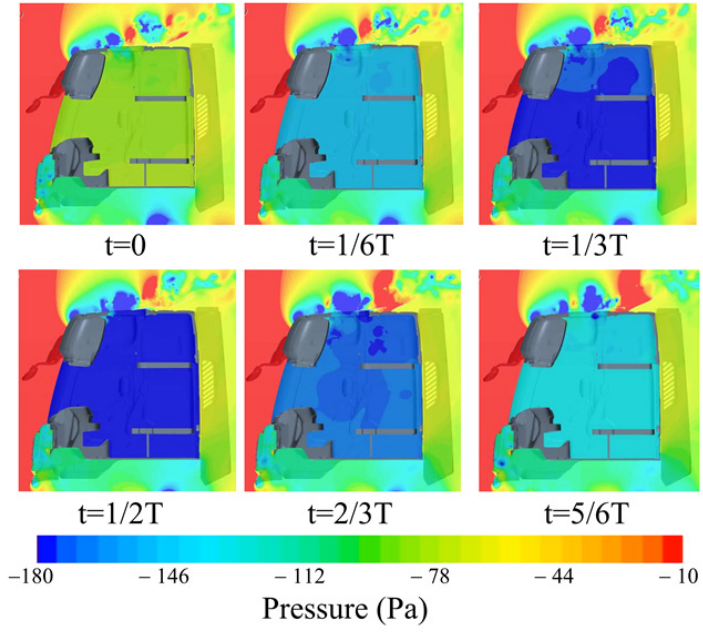
Figure 6. The transient pressure contour curve of the cab.